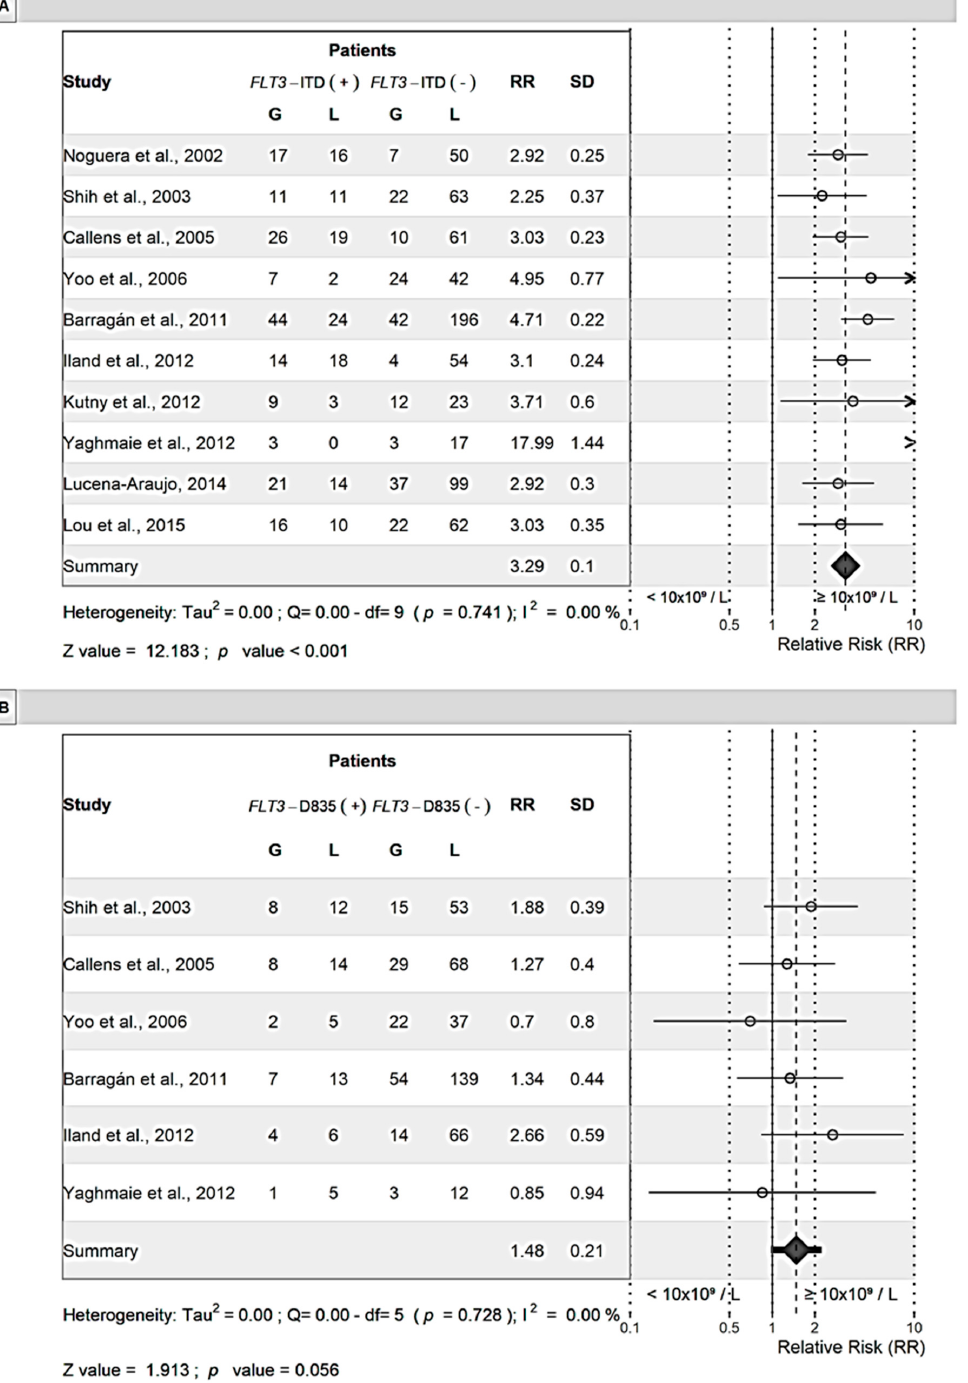
Figure 3. Meta-analysis of the relative risk (RR) by white blood cell count for FLT3 -ITD ( A ) and FLT3 -D835 ( B ) mutations. Mixed effect models were used for analysis. G: white blood cell count equal or greater than 10 × 10 9 /L and L lower than 10 × 10 9 /L. The numbers in each column represent the number of cases (patients).